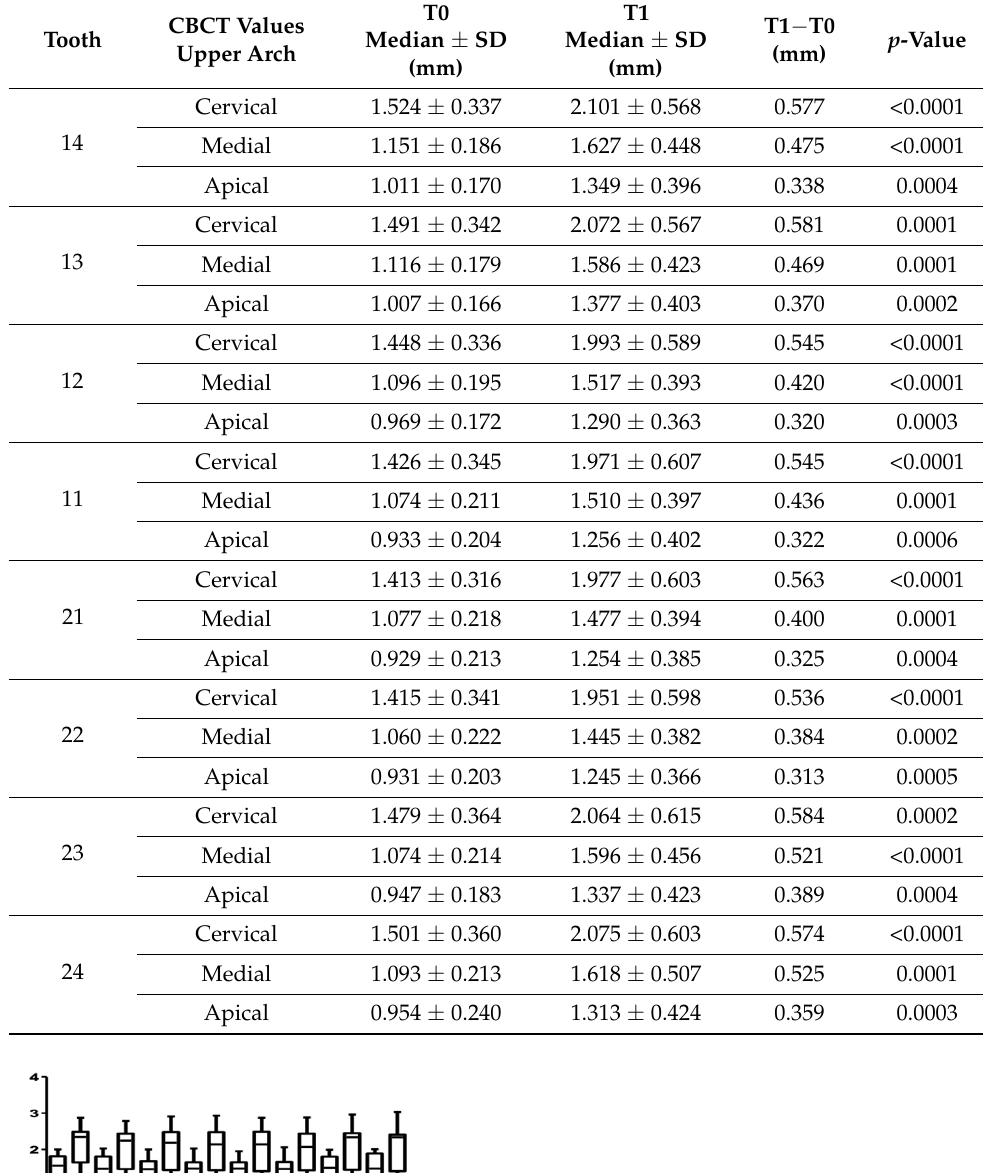
Table 3. Comparison of the level of buccal bone thickness at T0 and T1 for the maxillary teeth.